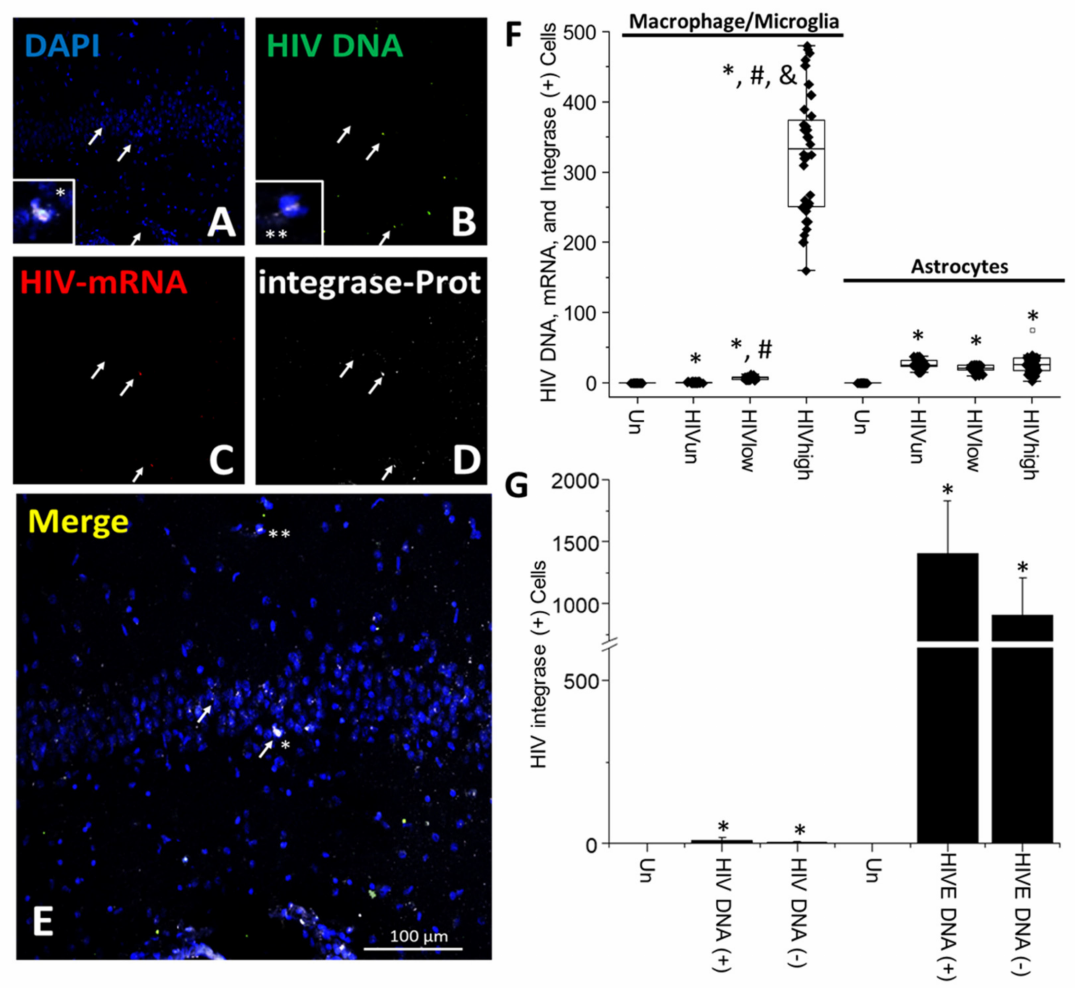
Figure 4. HIV-integrase protein is poorly expressed in HIV-infected cells under ART. ( A – E ) Rep- resentative confocal images showing the expression and distribution of integrase in the HIV-infected cells, showing minimal to no expression of integrase, where labeling corresponds to ( A ) DAPI, ( B ) HIV DNA, ( C ) HIV-mRNA, ( D ) HIV-integrase protein, and ( E ) merging of all colors. White ar- rows indicate cells with integrated HIV DNA. Asterisks and arrows indicate cells with high levels of cytoplasmic and nuclear integrase proteins. The insets indicate the colocalization of DAPI, HIV DNA, and integrase. ( F ) Quantification of cells with integrated HIV DNA, viral mRNA, and HIV-integrase protein according to its localization in Macrophage/Microglia or astrocytes in human brain tissues obtained from individuals with undetectable, low, and high viral replication (* p ≤ 0.005 compared to uninfected conditions, # p ≤ 0.005 compared to HIV un conditions, and & p ≤ 0.005 compared to HIV un or HIV low conditions; n = 34 tissues analyzed and 21 tissues compared to uninfected tissues, Un and Alz, n = 8 different tissues; each point represents 3–5 different areas per tissue analyzed). The total numbers of cells in HIVE conditions were 1406 ± 425 cells, 905 ± 357 cells were